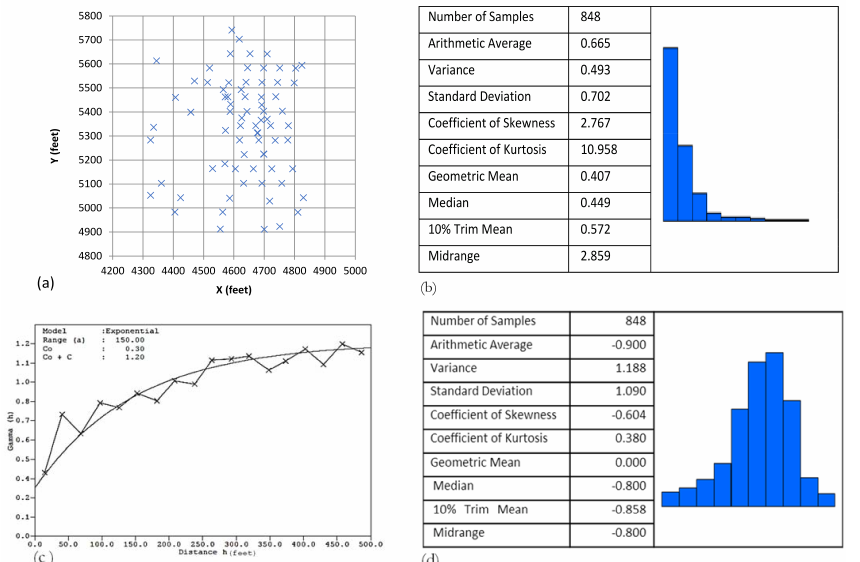
Figure 2. ( a ) Location of drill holes for the exploration of the Andina cooper deposit. ( b ) Statistical parameters and distribution of Cu% values of the composite samples. ( c ) Omnidirectional experimen- tal variogram of the log-transformed values of % Cu with the fitted exponential model. ( d ) Statistical parameters and distribution of the log-transformed values of Cu